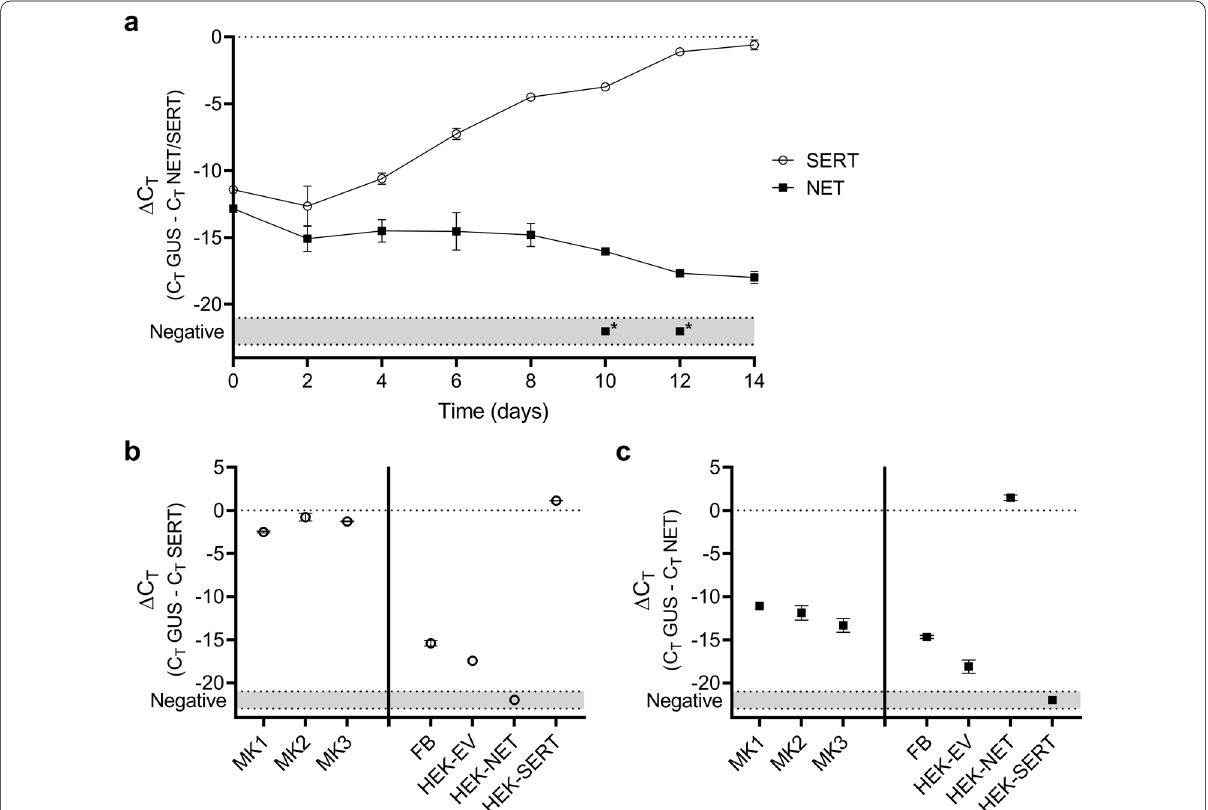
Fig.1 mRNA expression of SERT and NET in megakaryocytic cells evaluated using RT-qPCR. a mRNA expression of SERT and NET in CD34 + HSPCs undergoing megakaryocytic differentiation. Cells were cultured for 14 days, SERT and NET mRNA expression was evaluated every two days. b SERT mRNA expression of megakaryocytic cell culture batches from three different HSPC donors (MK1-3) after 10 days of differentiation. HEK-EV, HEK-NET, HEK-SERT are HEK293 cells were transfected with an empty vector, NET, or SERT, respectively, and served, in combination with fibroblasts (FB) as controls. c NET mRNA expression of MK1-3 after 10 days of differentiation. NET mRNA expression was also determined in fibroblasts (FB) and HEK293-EV, HEK293-NET, and HEK293-SERT. Results are expressed as mean SD (n 2, experiments in triplicate). *If a ΔC T could not be calculated ± = due to C T values of SERT or NET > 40 cycles, the sample was scored